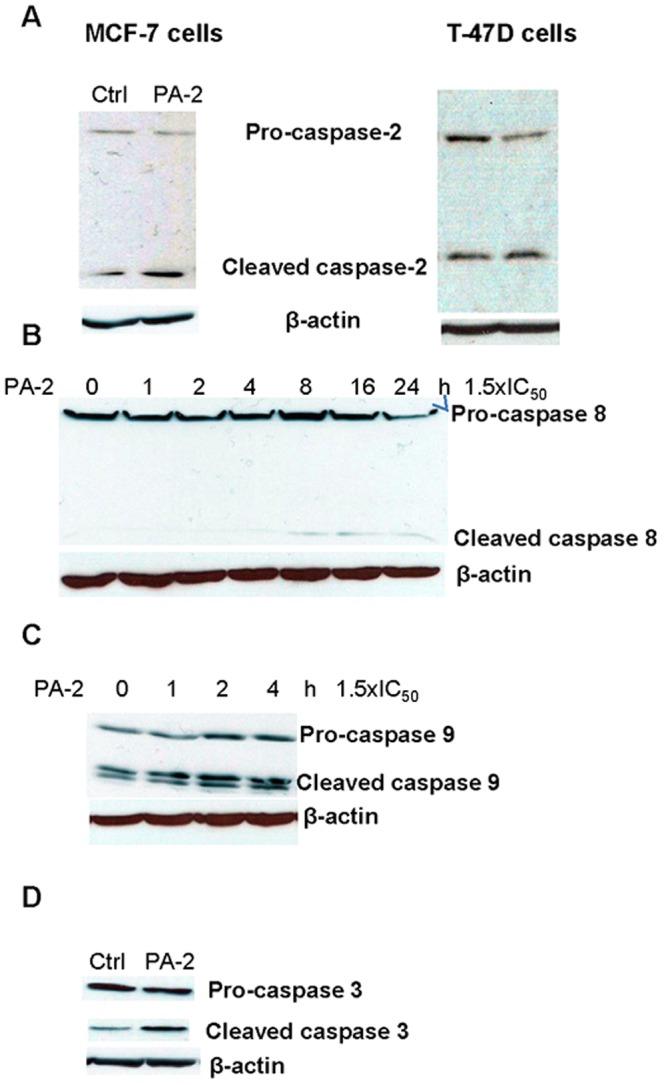
Phospho-aspirin-2 activates caspase cascades.PA-2 treatment in MCF7 or T-47 D cells resulted in decreased expression of pro-caspase-2, -8, -9 and -3 and increased expression of their cleaved forms, as determined by western blot.